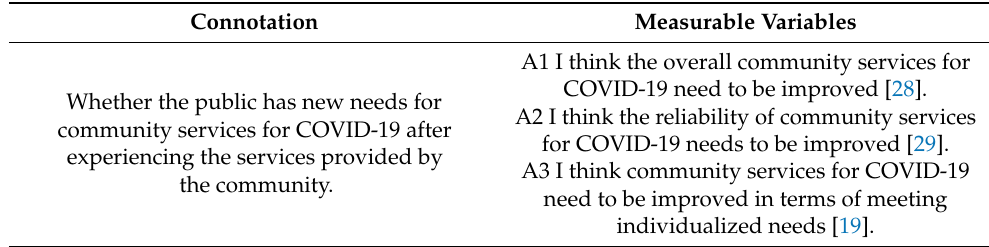
Table 1. Connotation and measurable variables of public